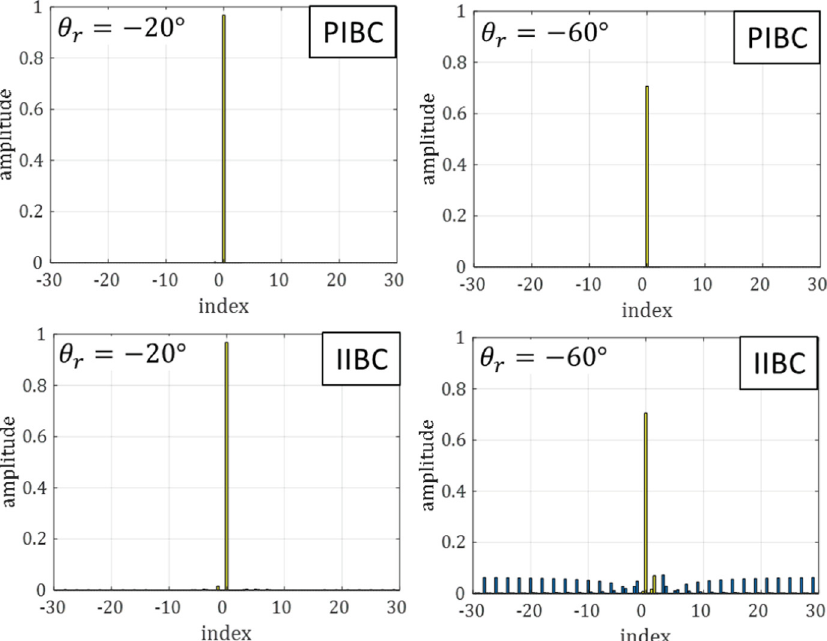
Fig. 4. Amplitude of the Floquet wave spectrum of the re fl ected electric fi eld for: (top) the PIBC solution in (5) and (bottom) the PIBC obtained by removing from the IIBC in (4) the contribution of the grounded slab evaluated at the incidence wavenumber. The amplitude of the FWs is shown for an TE-polarized incident wave at u i ¼ 0 ° and a TM-polarized re fl ected wave at u r ¼ (cid:3) 20 ° and u r ¼ (cid:3) 60 ° , with a permittivity of the dielectric of e r ¼ 9 : 8 .